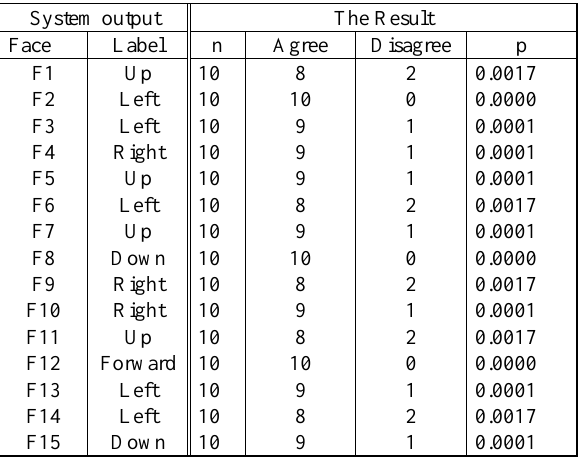
Table 2 . Chi-square Results For System